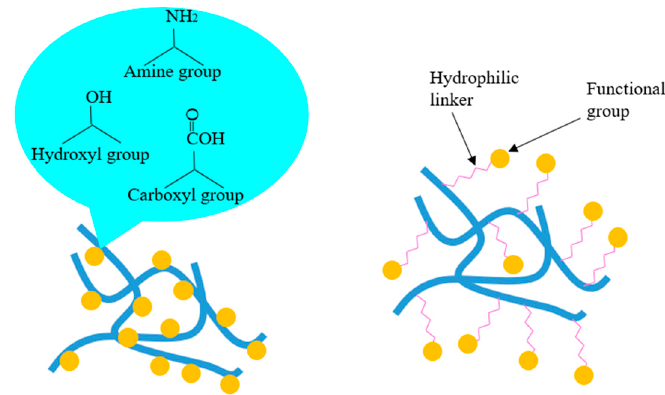
Figure 10. Common chemical adsorption of drug molecules onto the surface of nanofibers.